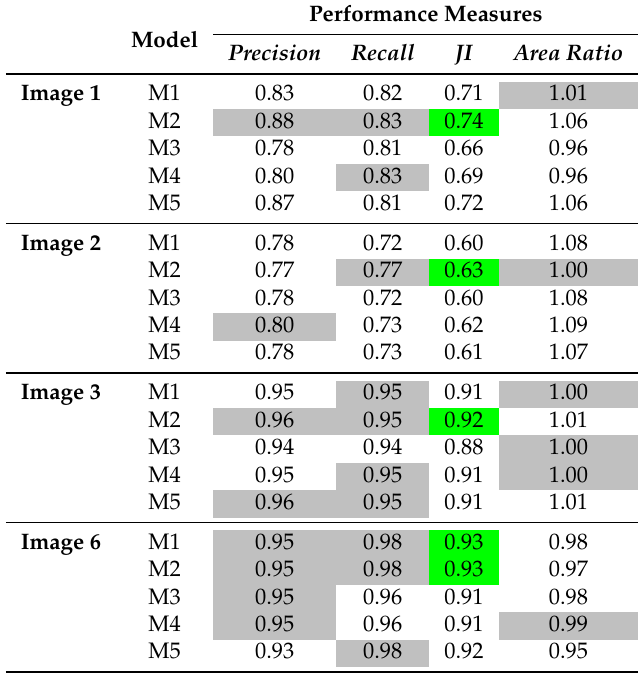
Table 3. Machine learning model results. Shading indicates best values of performance measure for each image. Green shading indicates the primary metric,